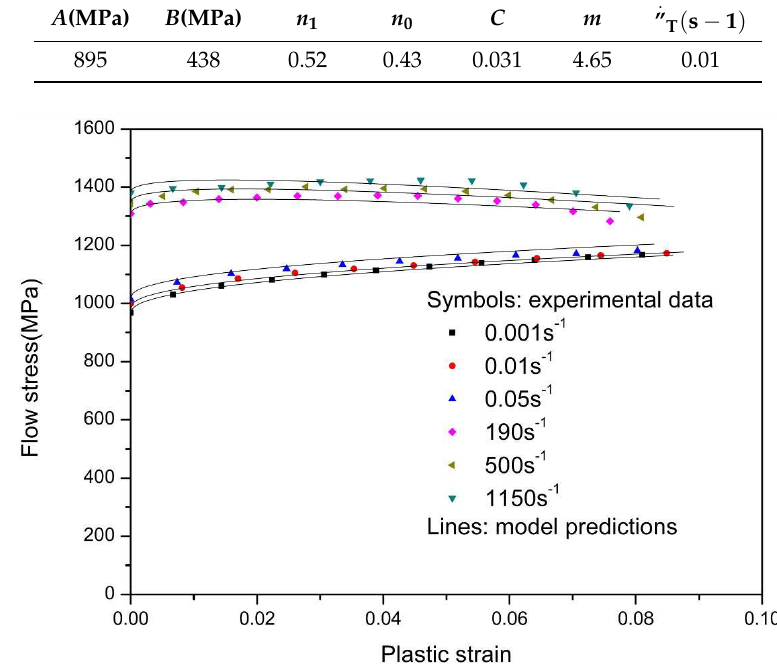
Figure 9. Comparison of model prediction with experimental results under different strain rates.